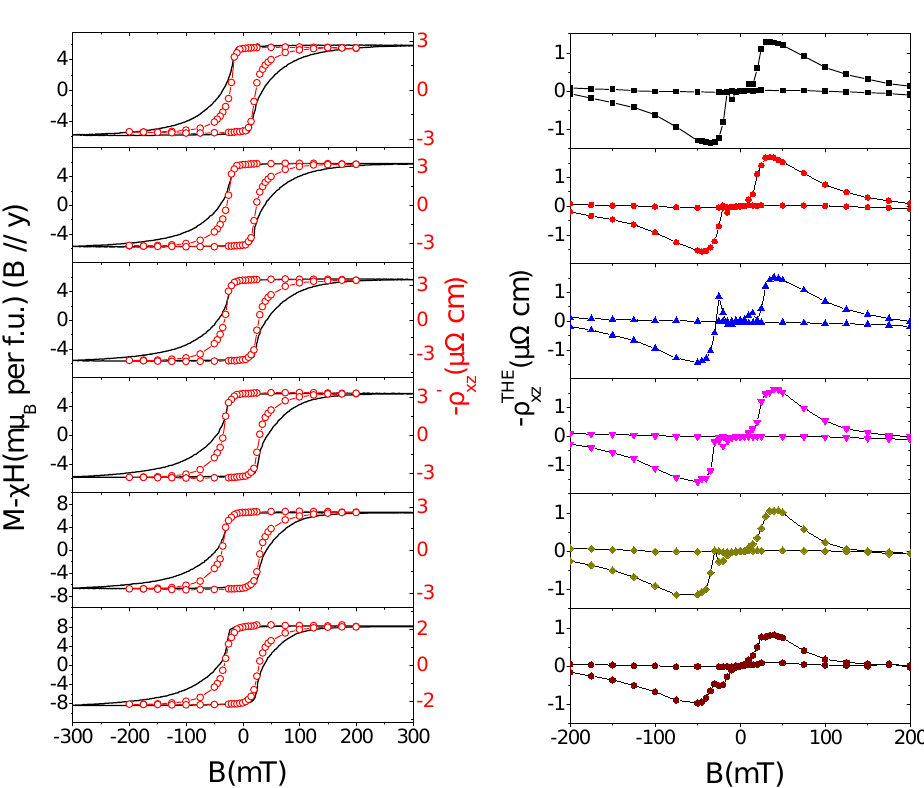
Figure S2: a) Comparison between the magnetization (with its high-field slope sub- tracted) and anomalous Hall resistivity for the magnetic field is along the y axis. These are similar to the case with the field along the x axis showed in the main text. The threshold field B is identical, but the magnetization shows a slower variation 0 at the end of the hysteresis loop. b) The topological Hall effect resolved by subtract- ing normalized magnetization times a constant from the Hall resistivity at different temperatures for a field along the y